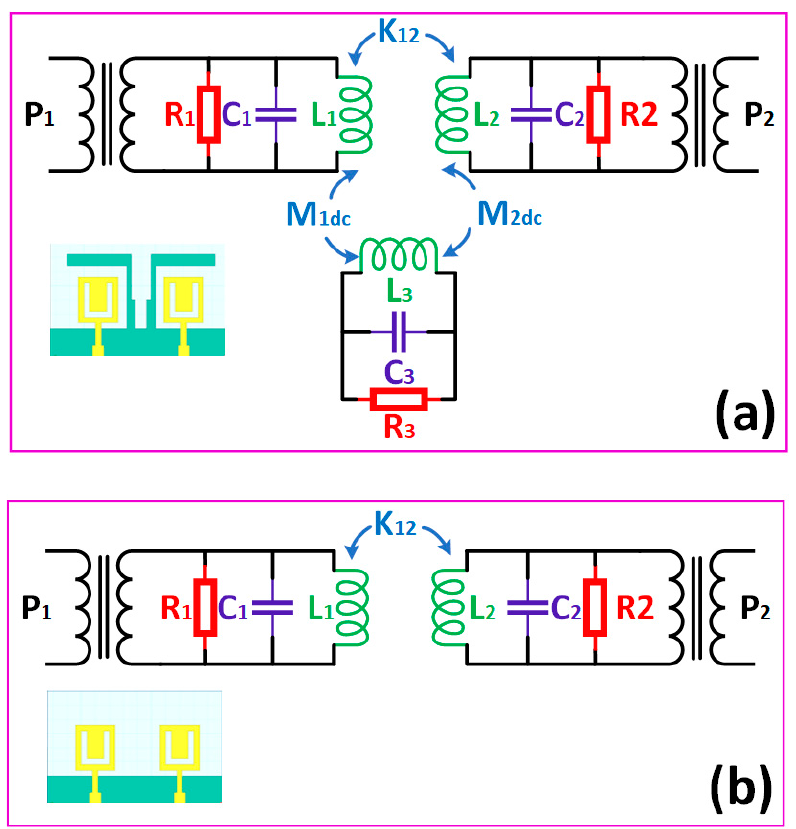
Figure 12. Possible equivalent RLC model for ( a ) Design 4 and ( b ) Design 3 structure of the proposed antenna.